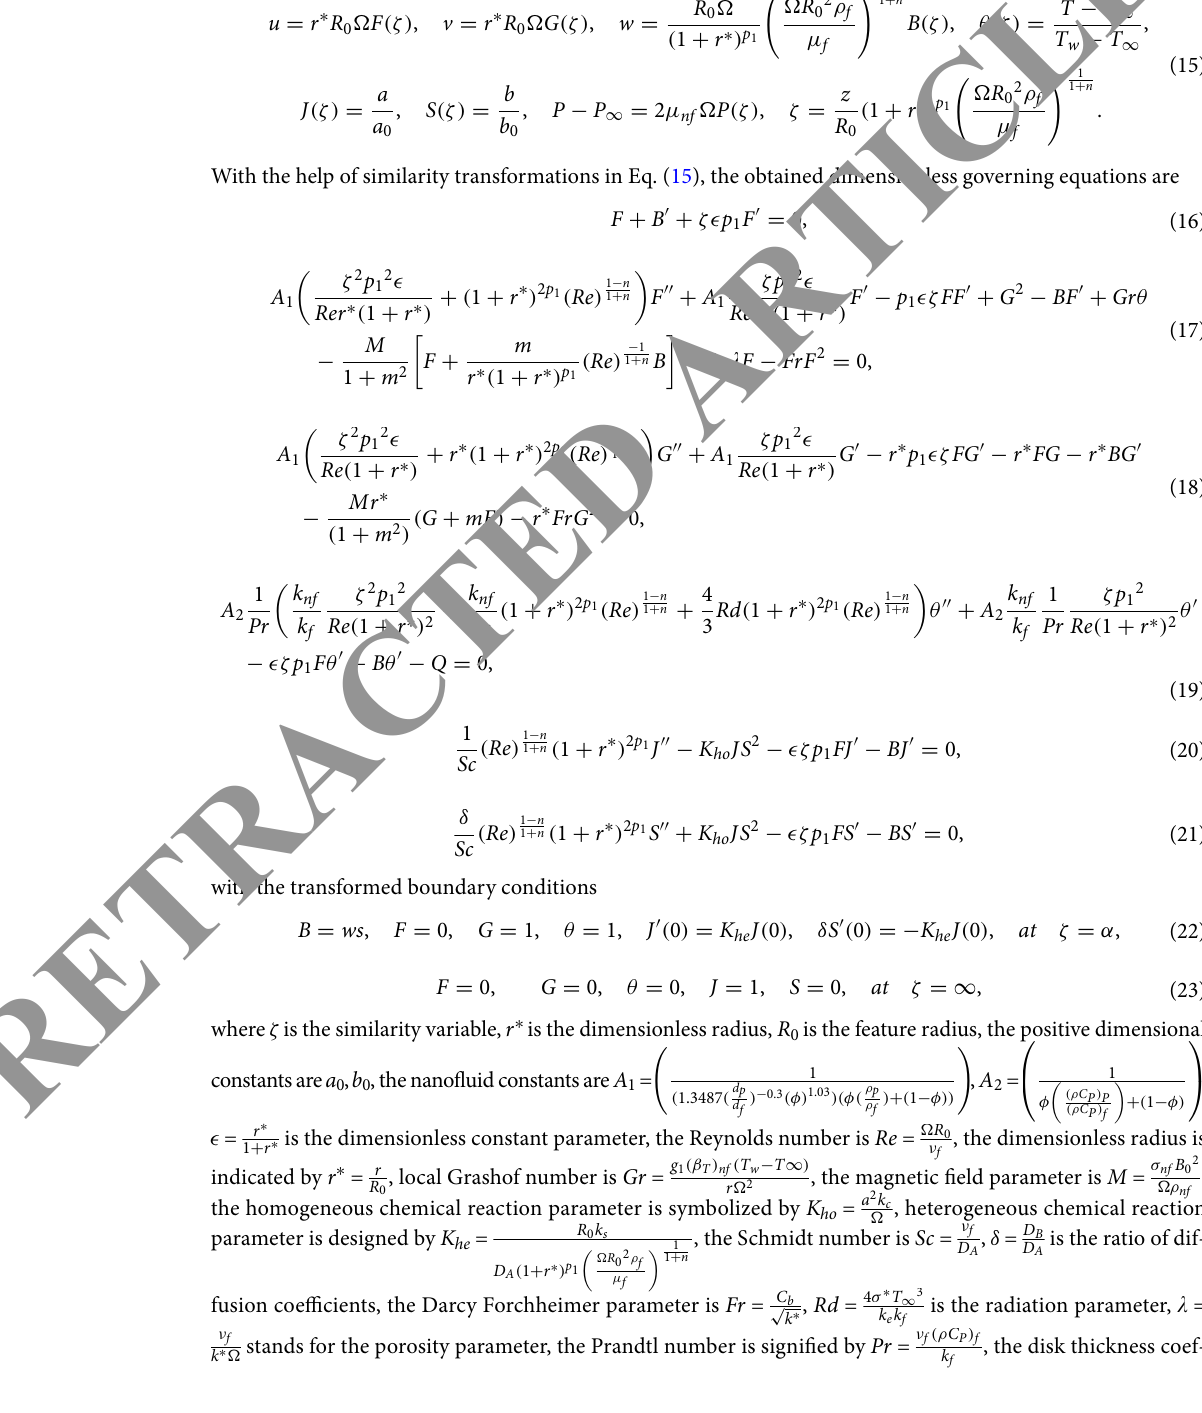
The similarity transformations are used as 42